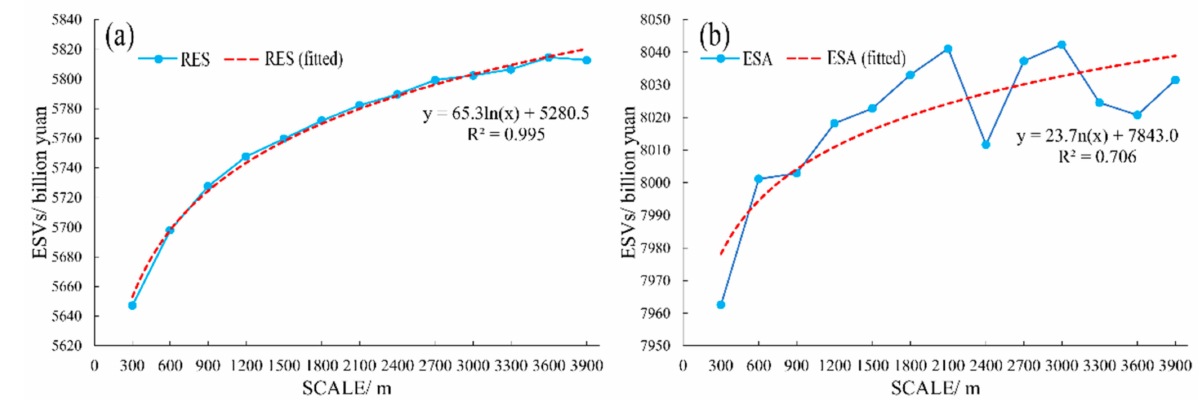
Figure 6. Change trends of the ESVs with RES ( a ) and ESA ( b ) LULC scale